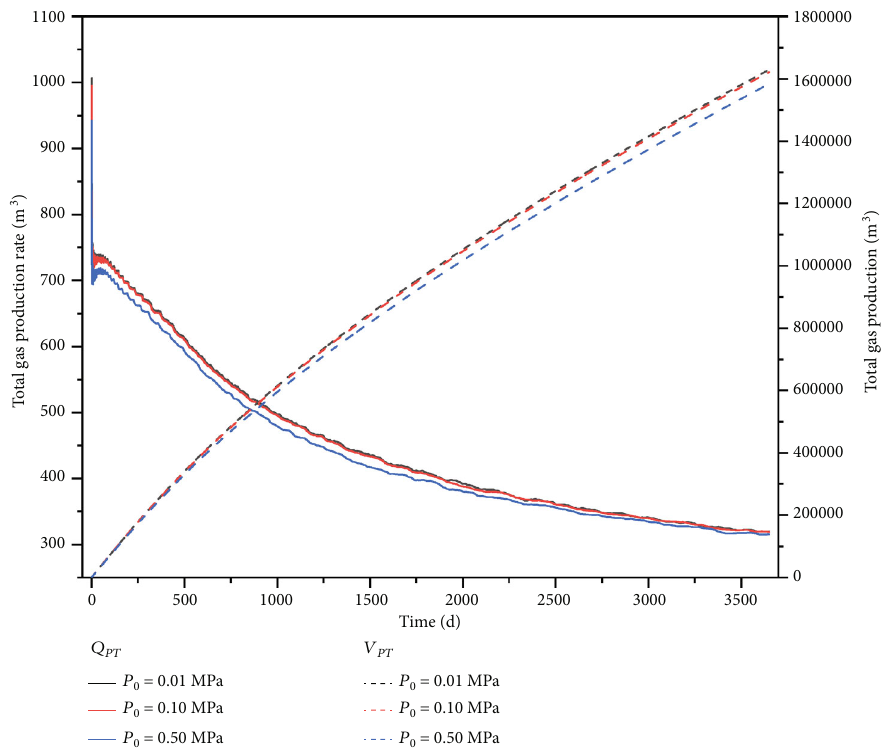
Figure 16: Evolution of total gas production rate Q